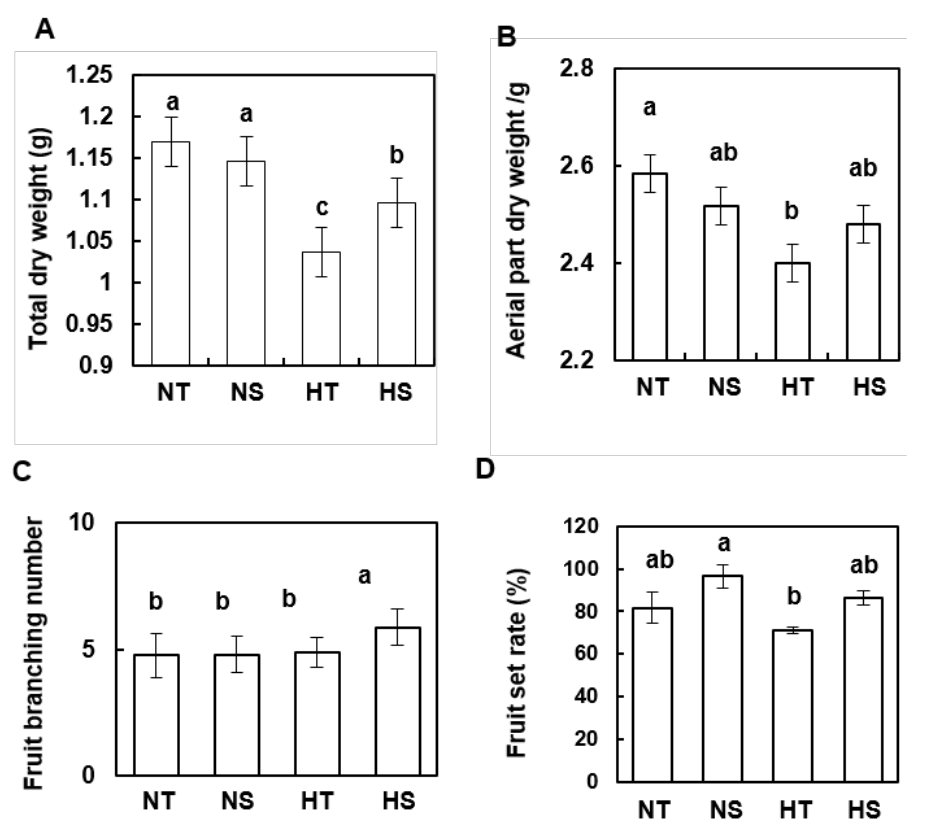
Figure 1. Effects of exogenous spermidine on biomass and fruit of tomato seedlings under high temperature stress: ( A ) Total dry weight; ( B ) Aerial part dry weight; ( C ) Fruit branching number; and ( D ) Fruit set rate. Note: NT, normal growth condition under 25/18 ◦ C and water; NS, normal growth condition under 25/18 ◦ C with 1 mM Spd treatment on plants; HT, high temperature growth condition on 38/28 ◦ C and water treatment; HS, high temperature growth condition on 38/28 ◦ C with 1 mM Spd treatment on leaves. Error bars represent SDs among three independent replicates. Different letters represent significant differences with p < 0.05 (Duncan’s multiple range tests).